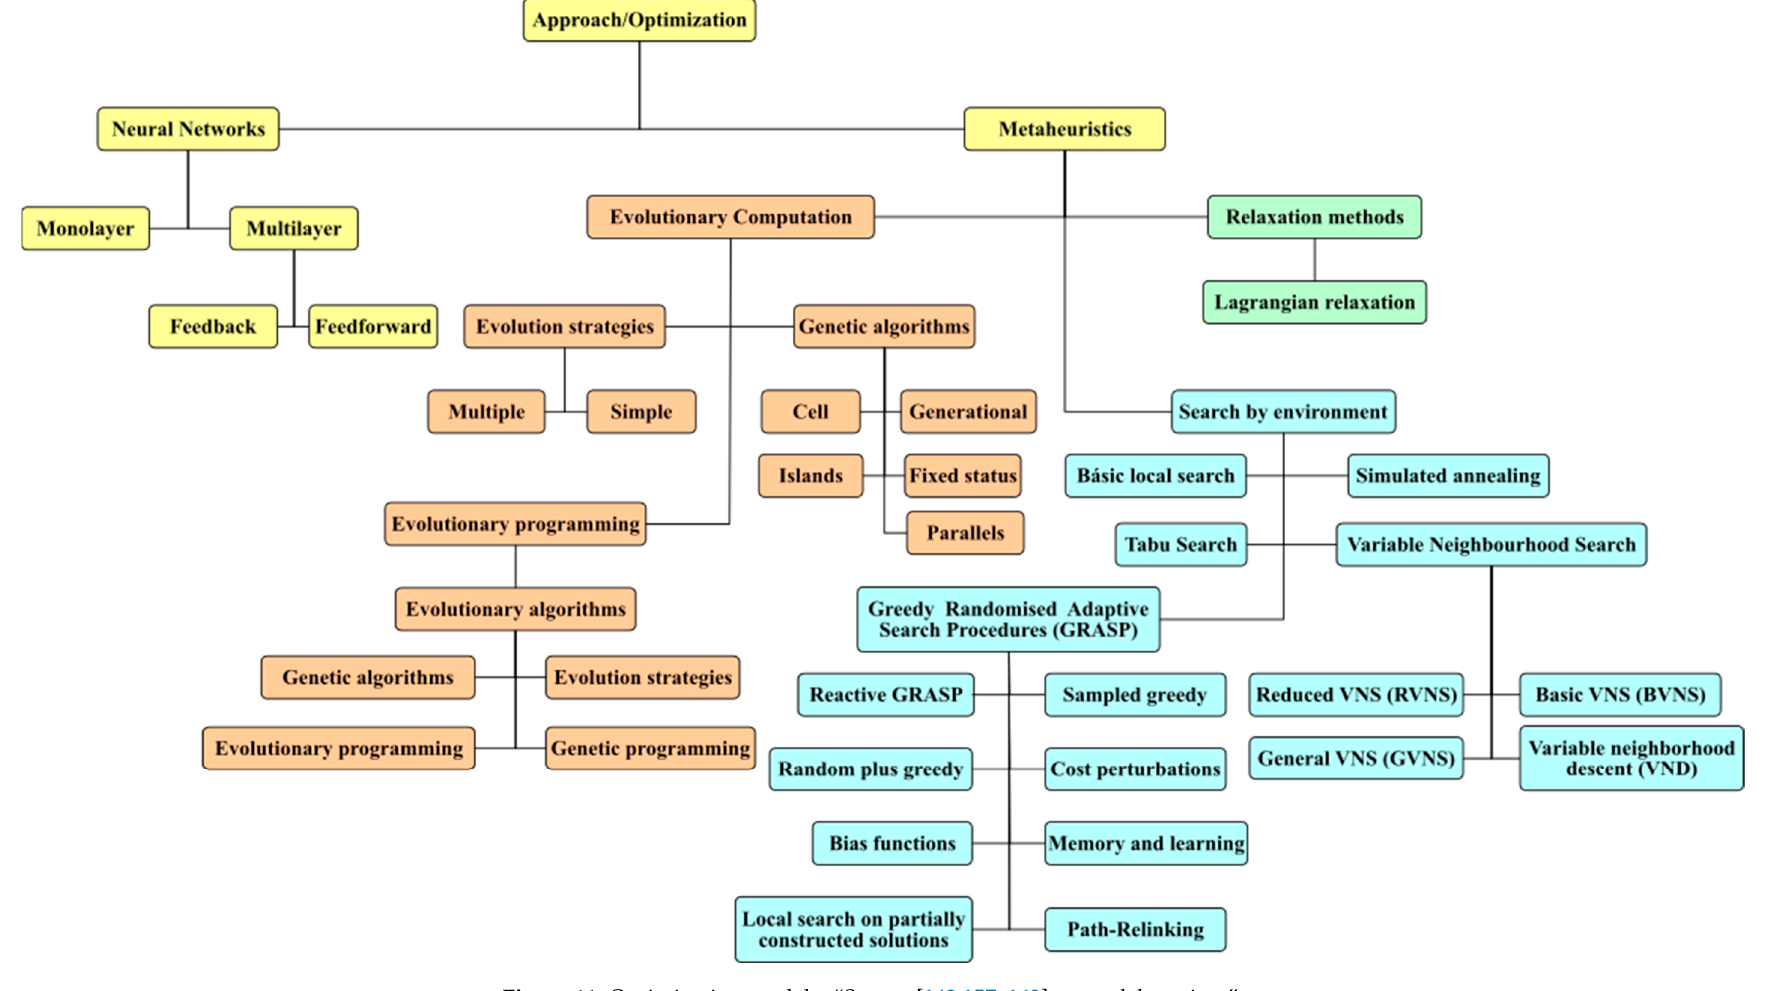
Figure 11. Optimization models. “Source [142,157–163], own elaboration.”.